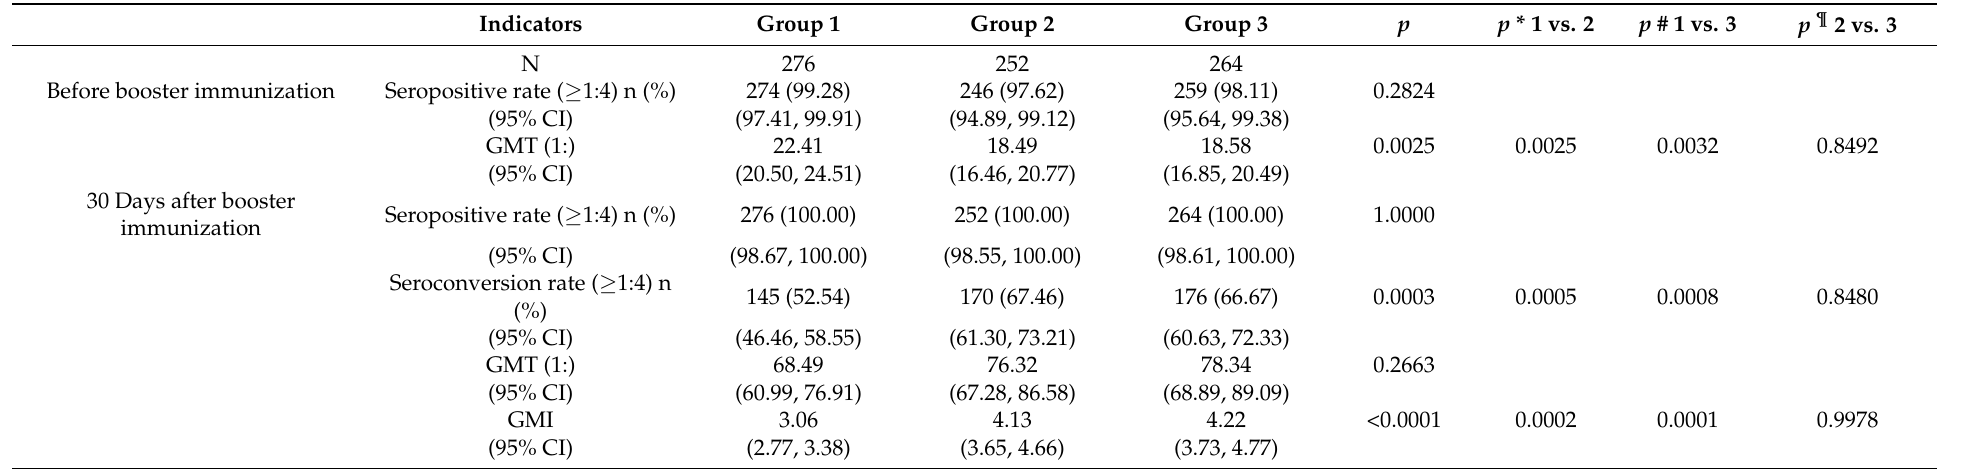
Table 3. The results of booster immunogenicity.